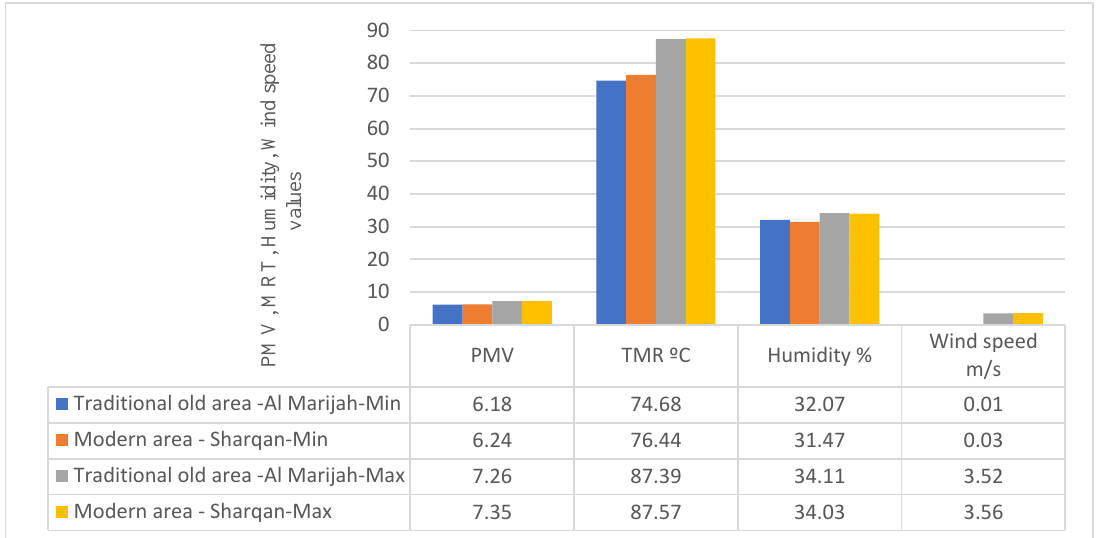
Figure 8. The PMV, MRT, humidity, and wind speed for both sites old and new on 21 August at 12:00 pm.